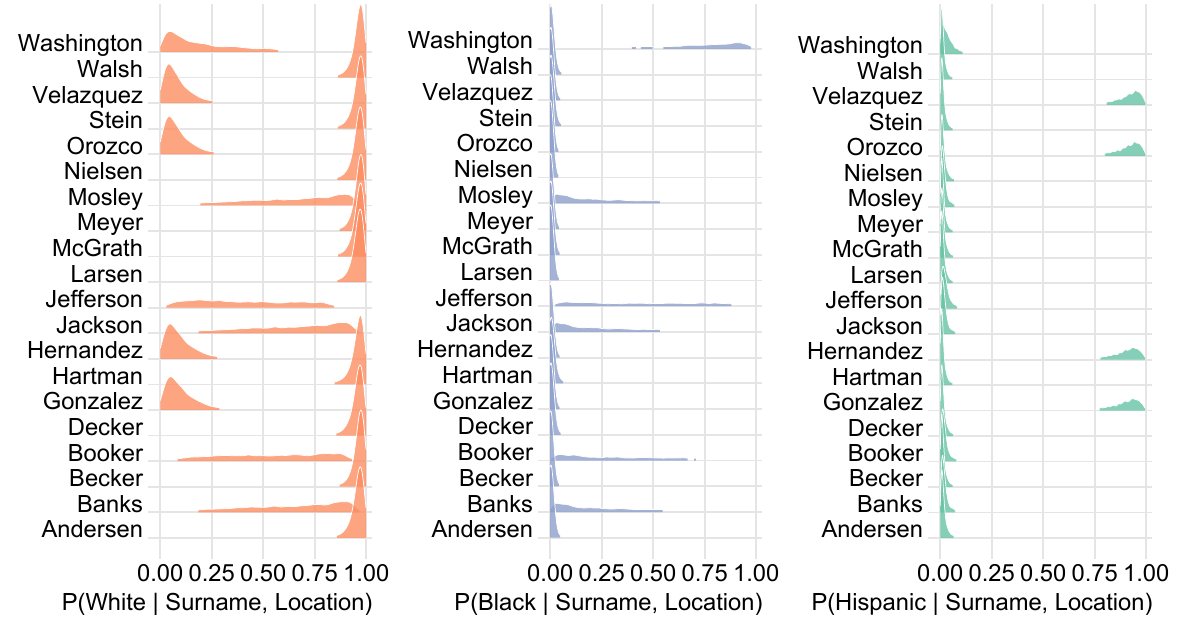
Figure 1: P ( R | S , L ) plots. The predicted probabilities of a name signaling a race (or ethnicity) across geographic locations are shown. The vertical axis lists 20 last names commonly used in audit studies. The horizontal axis displays the distribution of probabilities generated using Bayes’ rule. The probabilities of a name belonging to a race sum to 1. The left panel plots P ( white | S , L ) for each name, the middle panel plots P ( black | S , L ) , and the right panel plots P ( Hispanic | S , L )